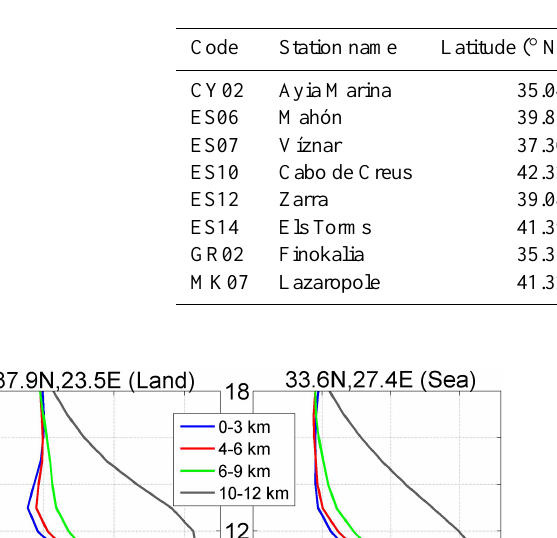
Table 1. List of geographic location of the EMEP O 3 monitoring ground stations used in this study, with the corresponding altitude above mean sea level.